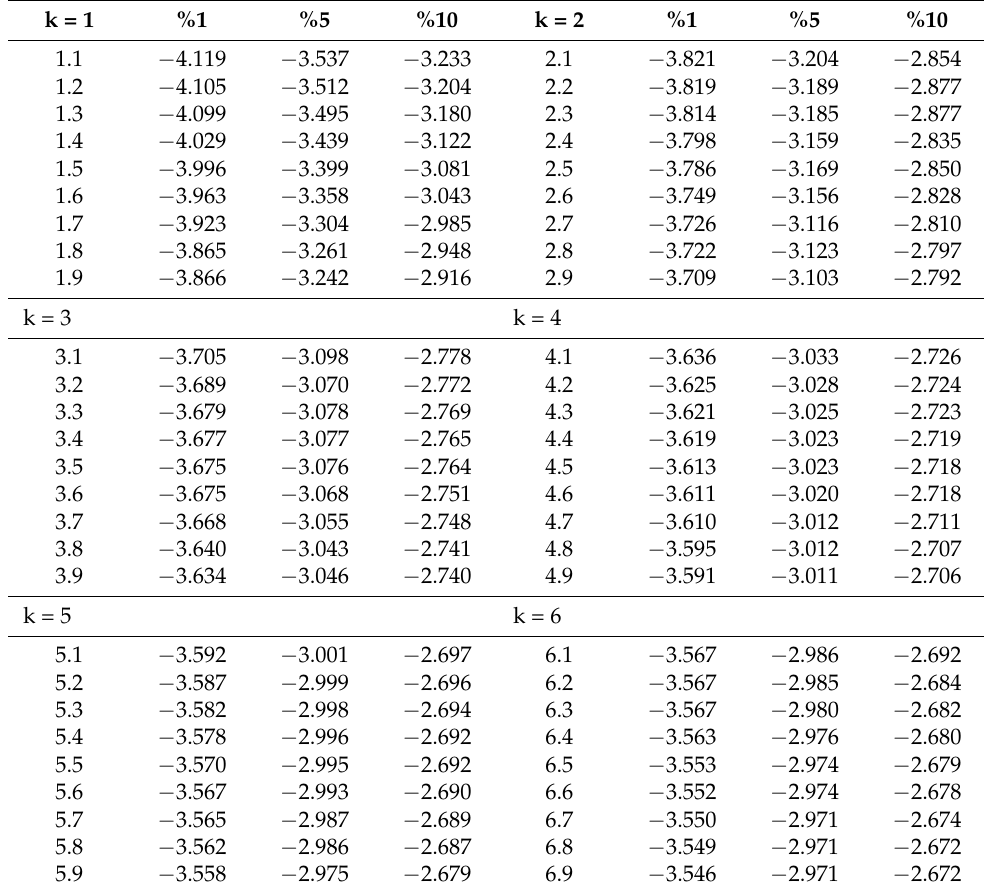
Table A1. Critical values for the one step intercept only